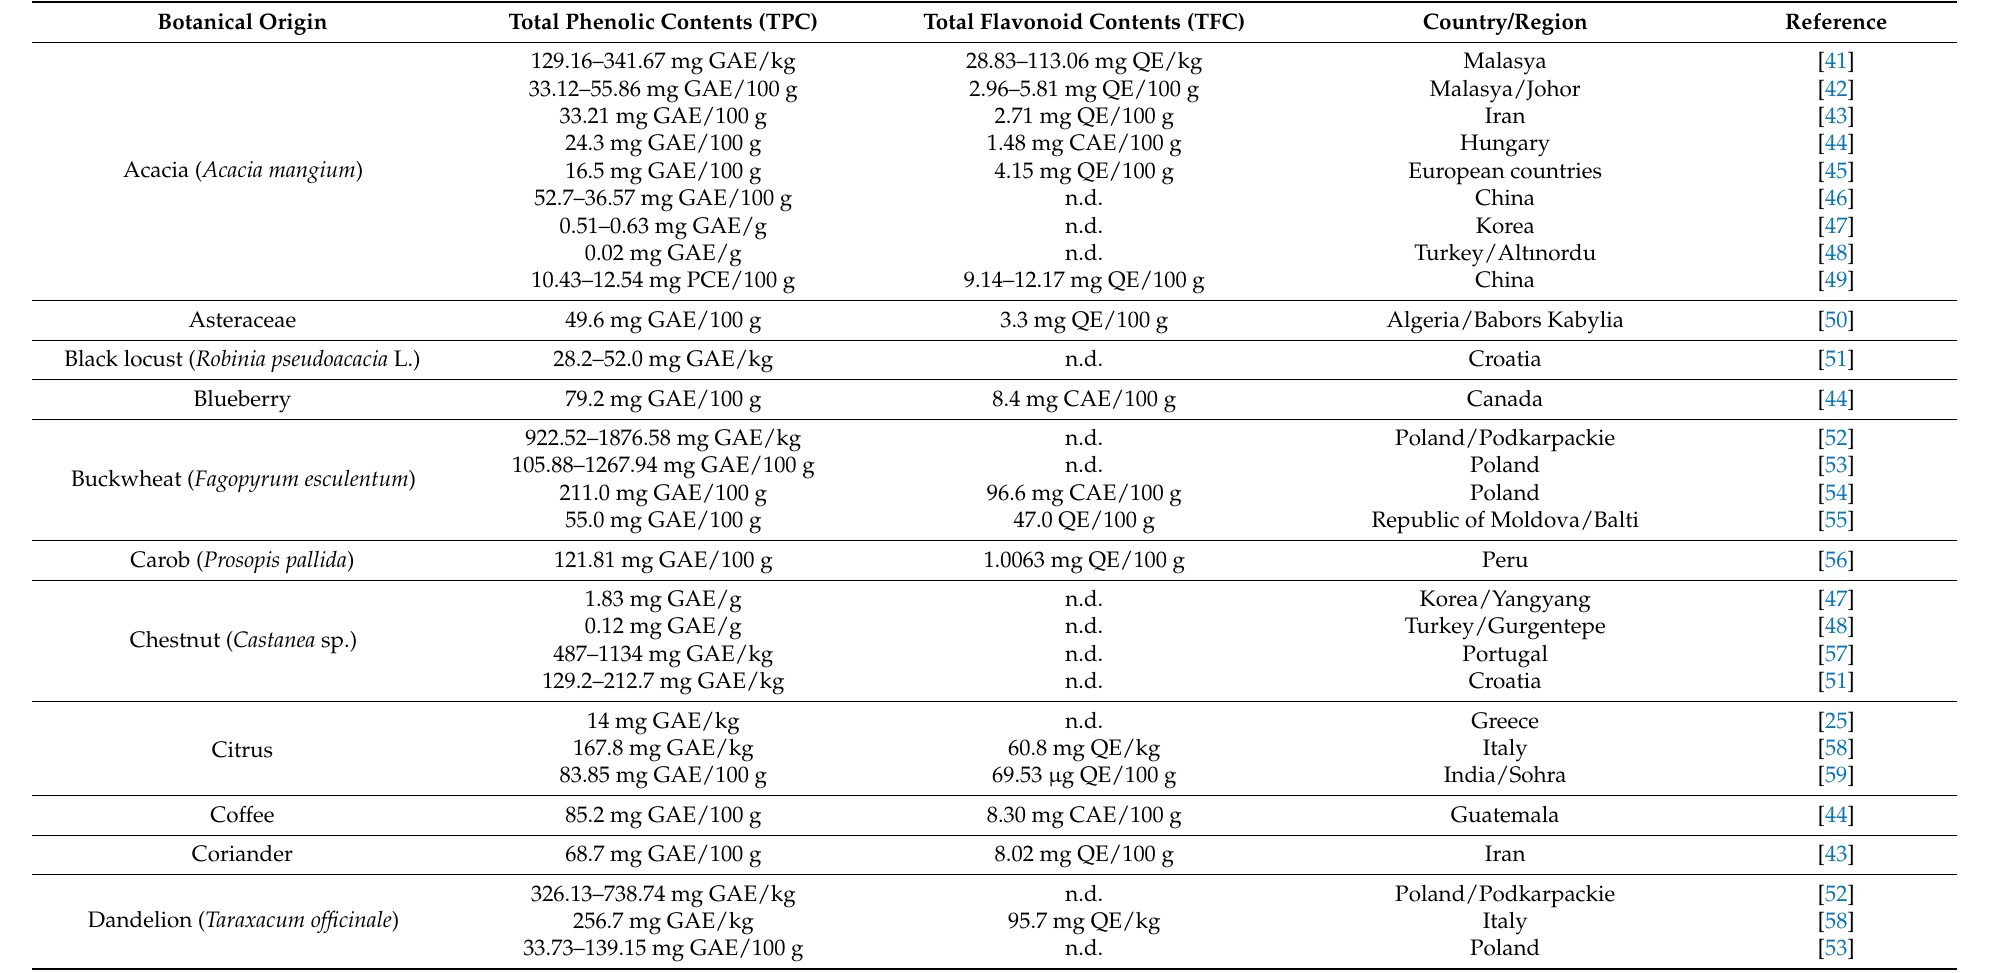
Table 1. Total Phenol Content (TPC) and Total Flavonoid Content (TFC) in honeys according to